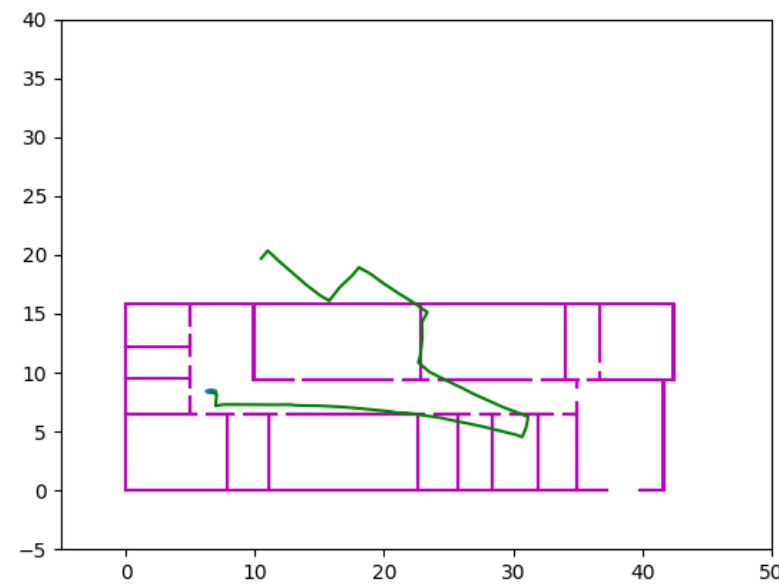
Figure 1. An example of how small error in rotation causes large error in location. The green line reflects the path received from INS. The purple lines define the walls. The proper path should start and finish at the same point. The estimated path ends with 12 m of error. The axes are defined in meters